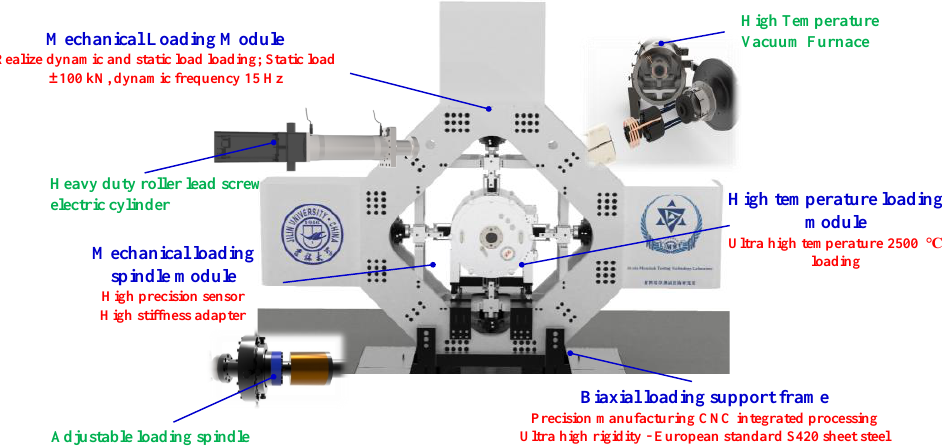
Figure 1. In-plane biaxial and high-temperature mechanical properties test apparatus.